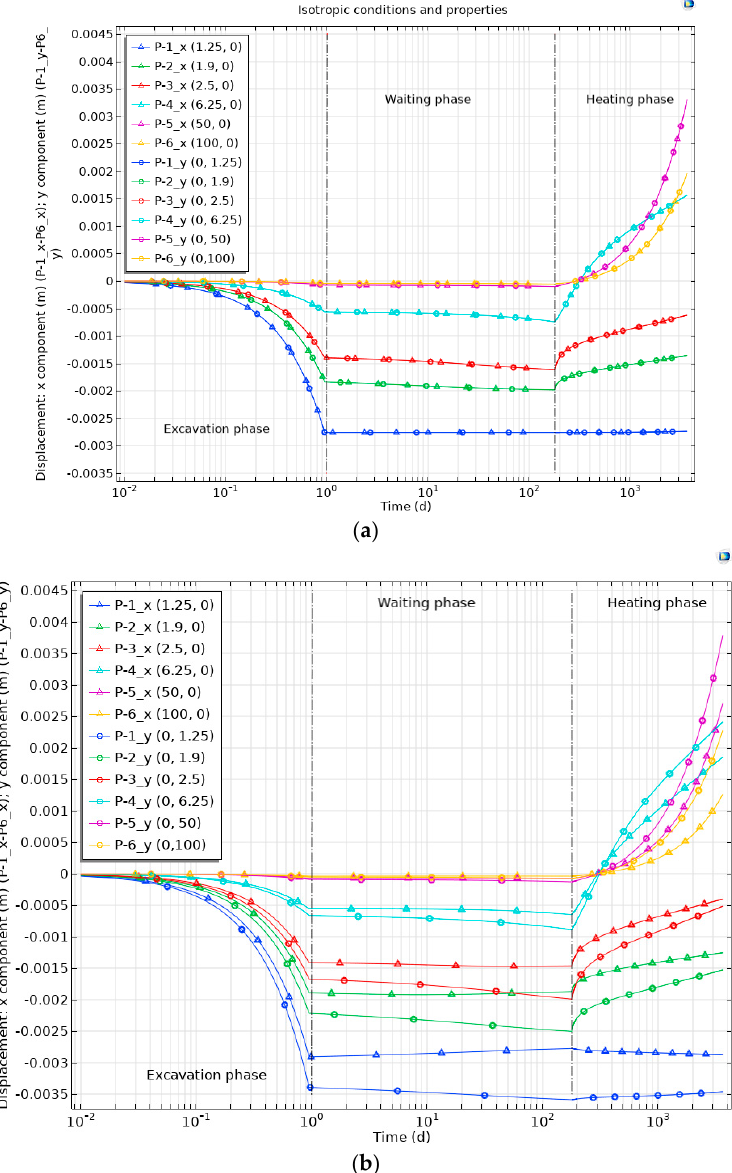
Figure 10. DC variant: evolution of displacement x component at selected points for comparison: ( a ) isotropic stress conditions and isotropic properties, ( b ) anisotropic stress conditions and anisotropic properties.